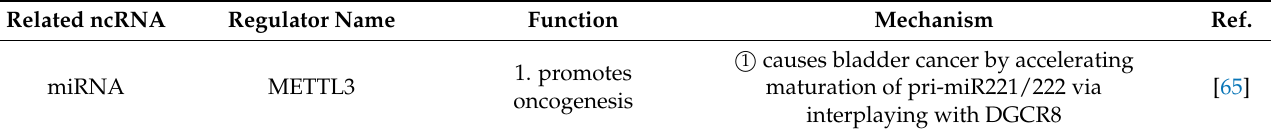
Table 2. The relationship between ncRNA and m6A regulators in